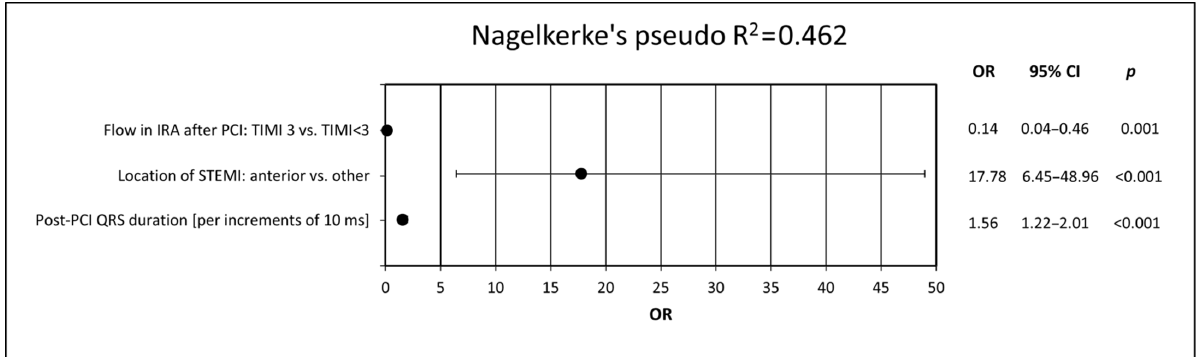
Figure 3. Predictors of LVSD presence after 6 months of follow-up. The model was created using multivariate logistic regression analysis by adding all electrocardiographic variables to the demographic, clinical, angiographic and biochemical data. CI, confidence interval; IRA, infarct-related artery; LVSD, left ventricular systolic dysfunction; ms, milliseconds; OR, odds ratio; PCI, percutaneous coronary intervention; STEMI, ST-segment elevation myocardial infarction, TIMI, thrombolysis in myocardial infarction score.